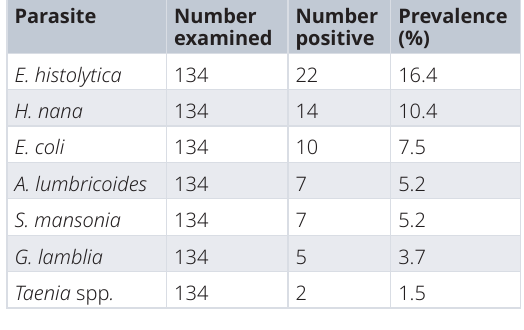
Table 3. Prevalence of intestinal parasite according to species.